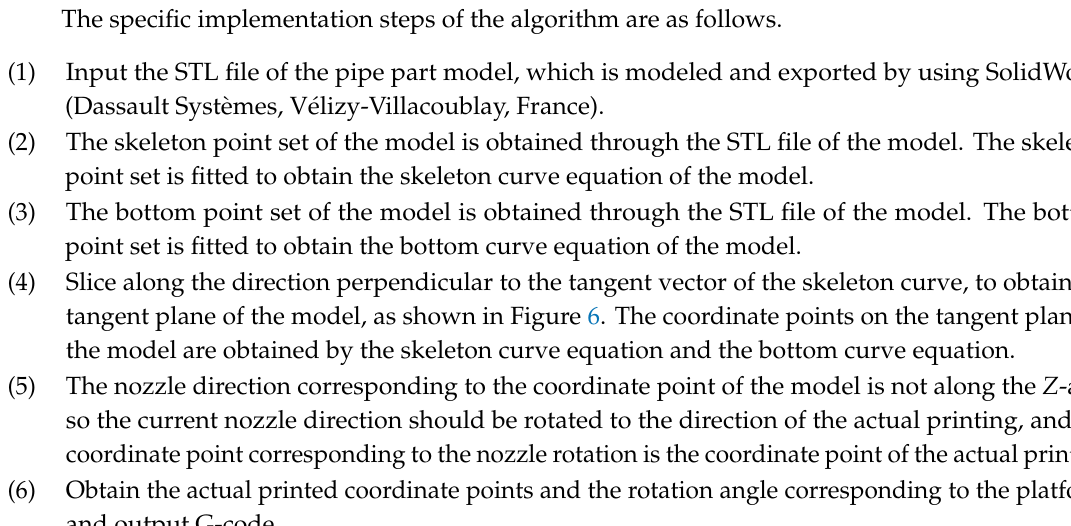
Figure 6. The slicing method of pipe parts model.